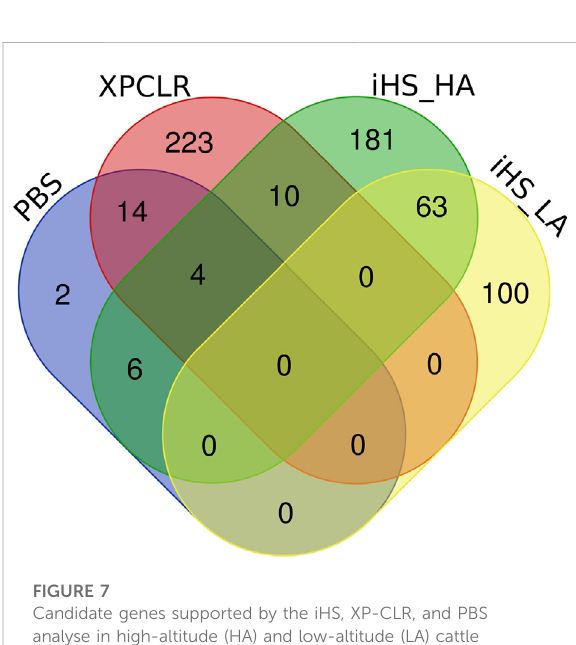
FIGURE 7 Candidate genes supported by the iHS, XP-CLR, and PBS analyse in high-altitude (HA) and low-altitude (LA) cattle